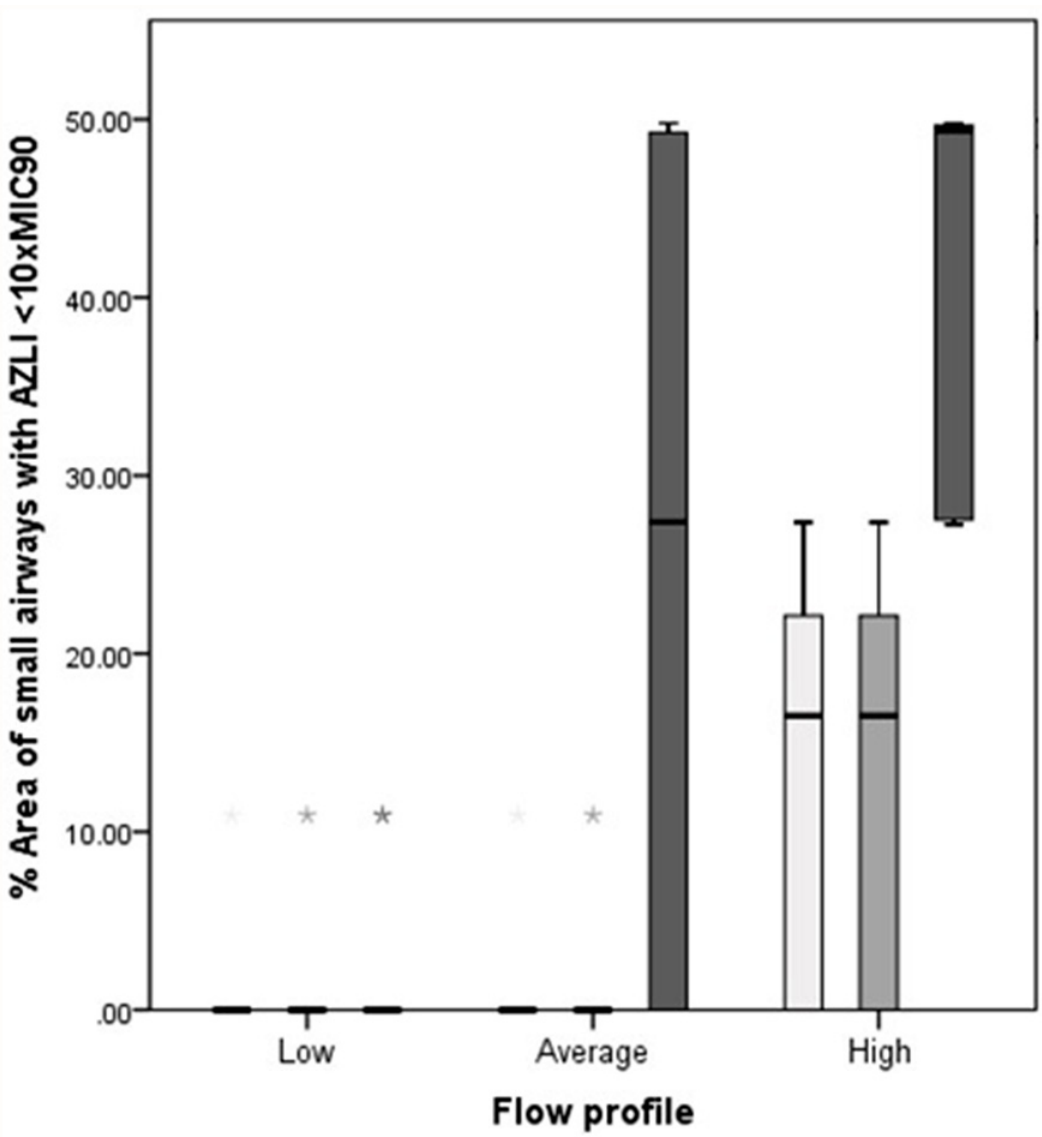
Fig 6. Influence of inhalation technique on AZLI concentrations. Influence of inhalation technique on AZLI concentrations presented as percentage area of small airways with AZLI < 10xMIC 90 . Low breathing profile: tidal volume of 6 ml/kg (228 ml) and respiration rate of 14 breaths/min. Average breathing profile: tidal volume of 10 ml/kg (380 ml) and respiration rate of 18 breaths/min. High breathing profile: tidal volume of 14 ml/kg (532 ml) and respiration rate of 22 breaths/min. Data are presented as median (range) for the different scenarios. Light grey bars represent the scenario of median ASL (5 μ m) with largest aerosol diameter (4.35 μ m). The darker grey bars represent the scenario of thick ASL (7 μ m) with median aerosol diameter (3.18 μ m) and the darkest grey bars represent the scenario of thick ASL (7 μ m) with largest aerosol diameter (4.35 μ m). The scenarios of thin ASL with all diameters, median ASL with smallest and median diameter and thick ASL with smallest diameter are not represented as all breathing profiles resulted in AZLI concentrations above 10xMIC 90 . ASL = airway surface